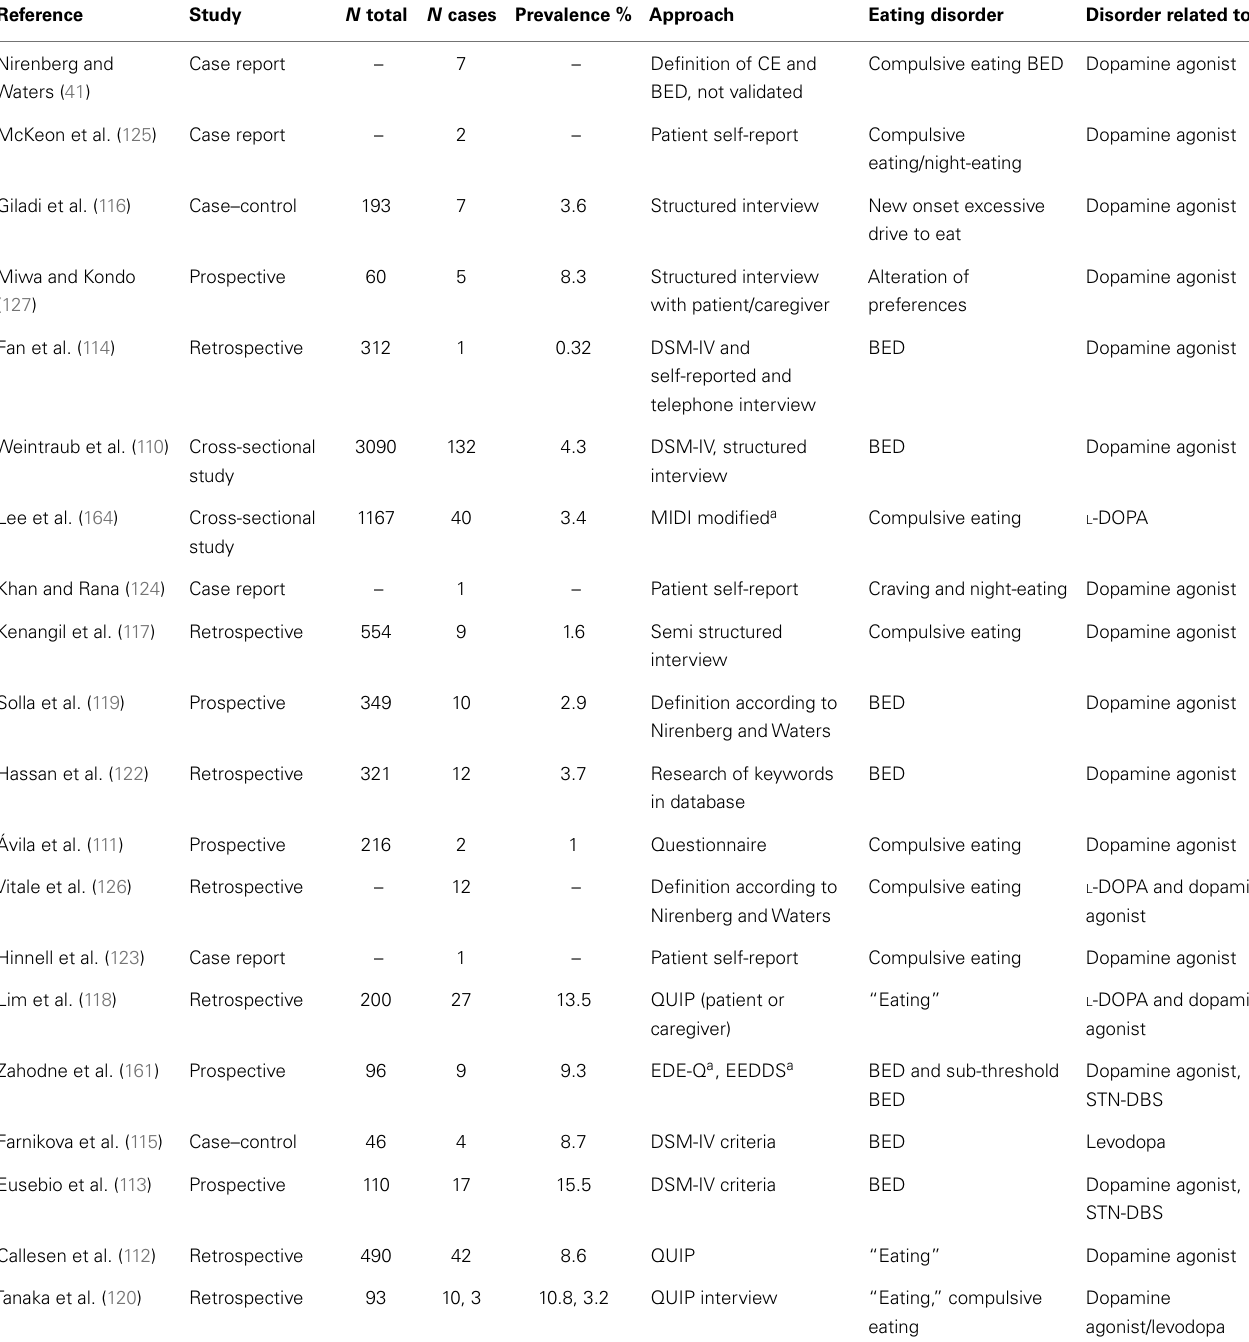
Table 3 | Eating disorders in PD